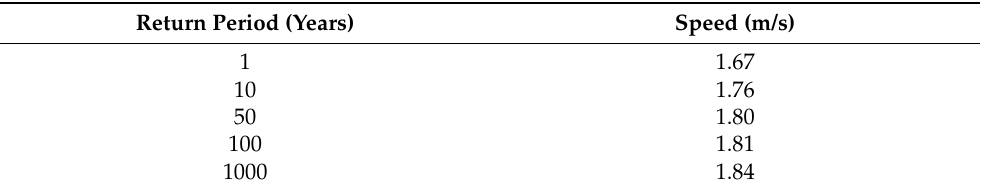
Table 3. Extreme criteria for currents for 5 different return periods. Extreme were derived by selecting currents speeds associated to accelerations at the level of maximum acceleration that are above the specified threshold of 0.01 m/s 2